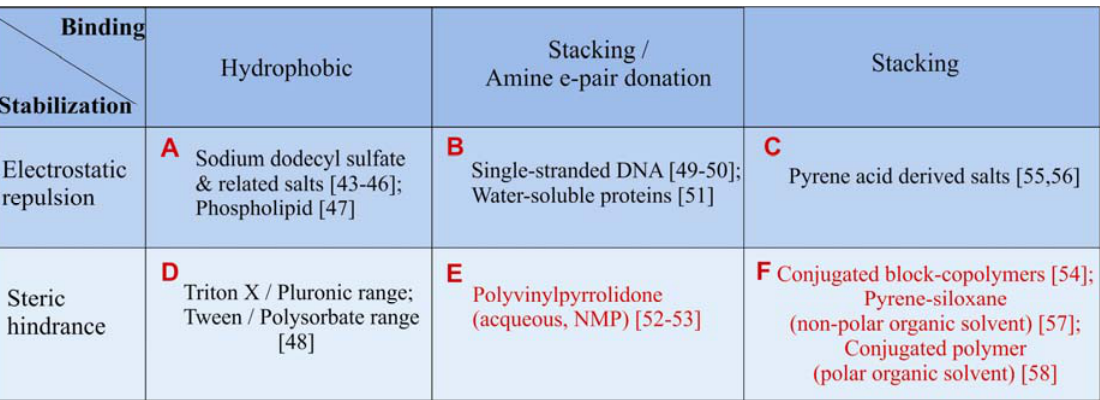
Table 1. Summary of dispersion mechanisms for various surfactants. The surfactants are divided into six generic groups, labeled A–F. The ones which are highlighted in red are for dispersion in organic solvents, whereas the rest are for dispersion in aqueous